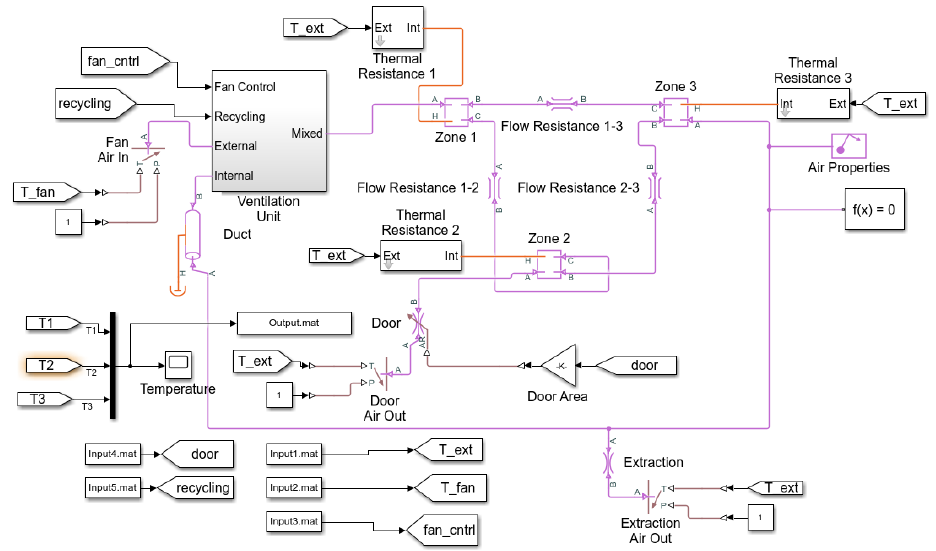
Figure 2. The building ventilation schematic